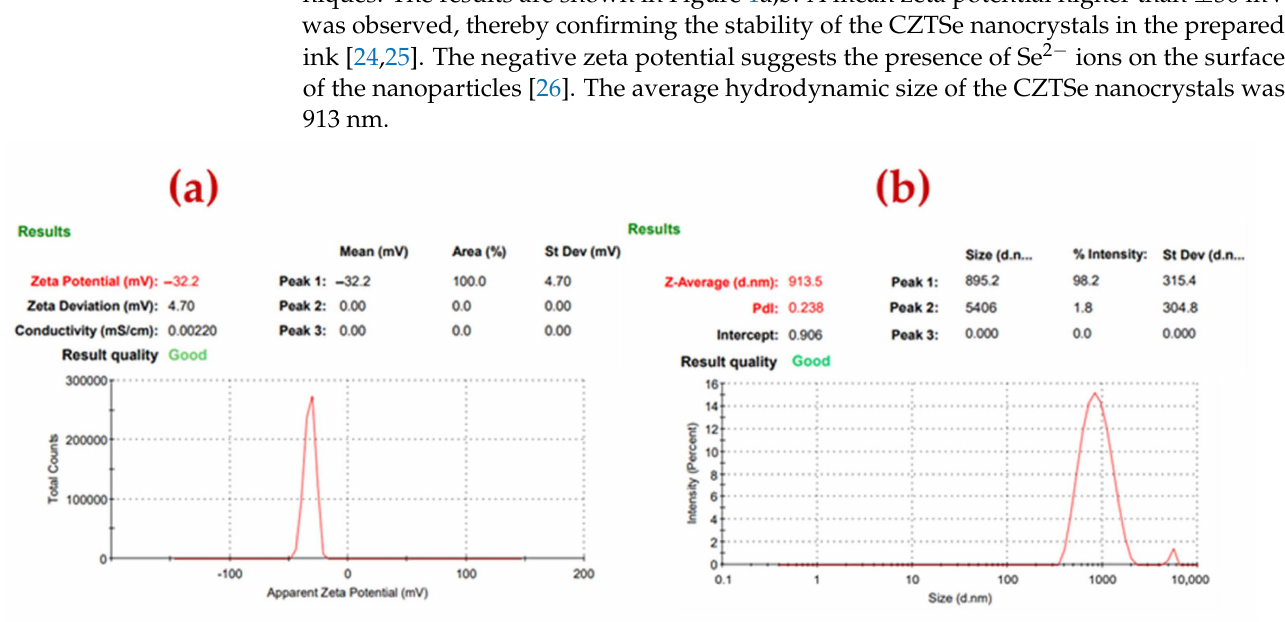
Figure 1. ( a ) Zeta potential and ( b ) DLS of CZTSe